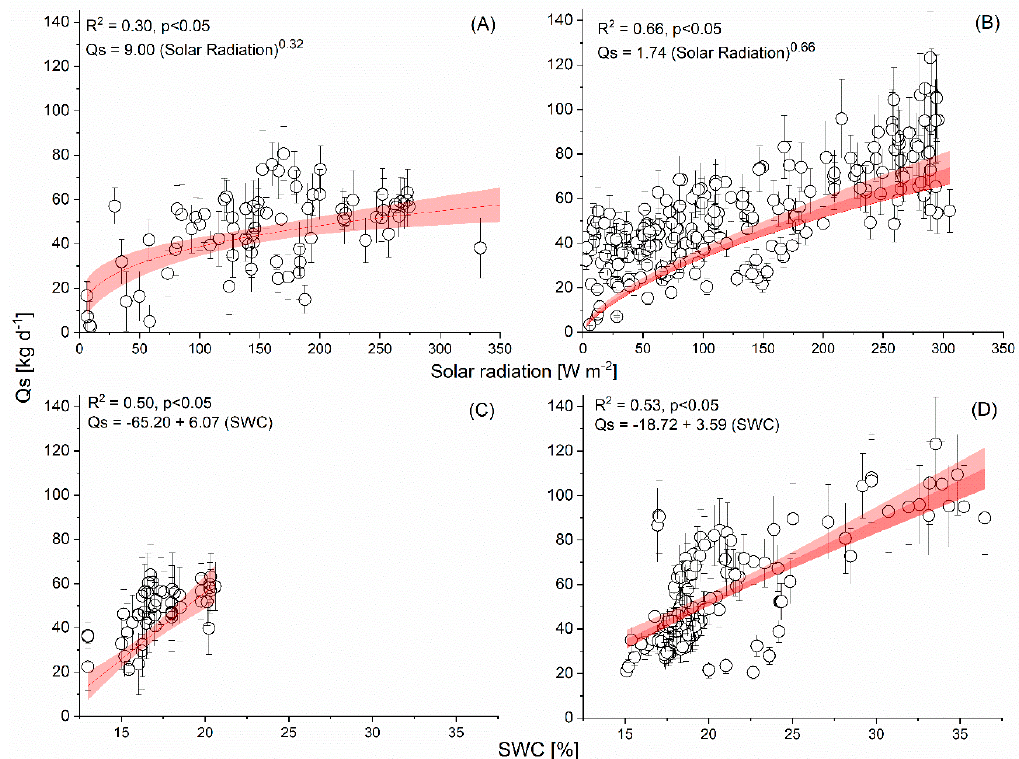
Figure 4. Relationships between Qs [kg d − 1 ] and climatic parameters during the dry period ( left ) and the wet period ( right ) are shown by the regression models between Qs and solar radiation when SWC > 20% ( A , B ) and SWC when VPD > 0.7 KPa ( C , D ). Symbols indicate mean values, error bars indicate ± SE ( n = 5 trees) and shaded bands indicate confidence level of the regression models at p < 0.05.